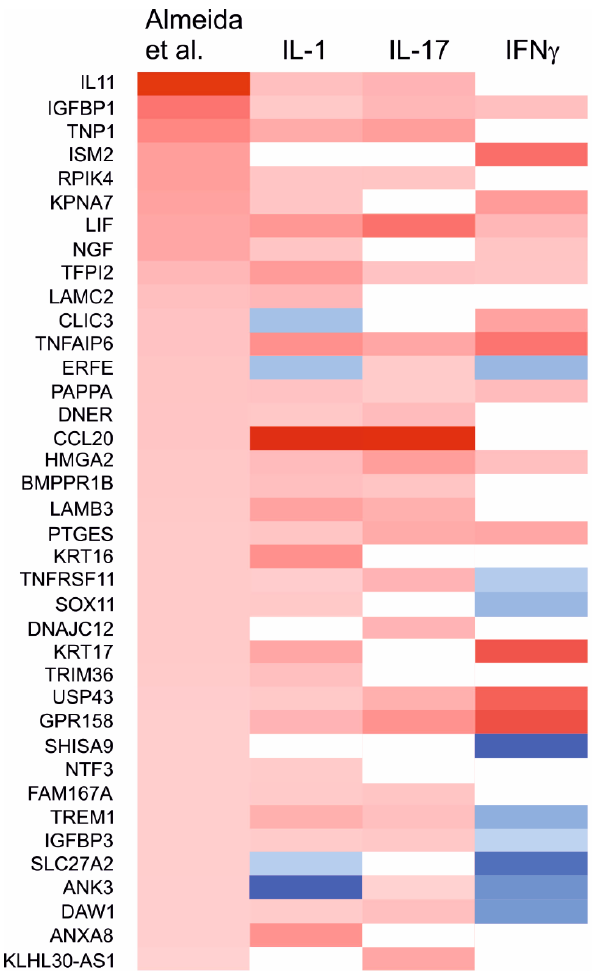
Figure 2. Heatmap of genes markedly upregulated (FC > 2.5) in degraded cartilage in the study by Almeida et al. [35] and significantly affected by at least one studied proinflammatory cytokine. Upregulated genes are marked with red, downregulated with blue, and genes with no significant fold change with white.